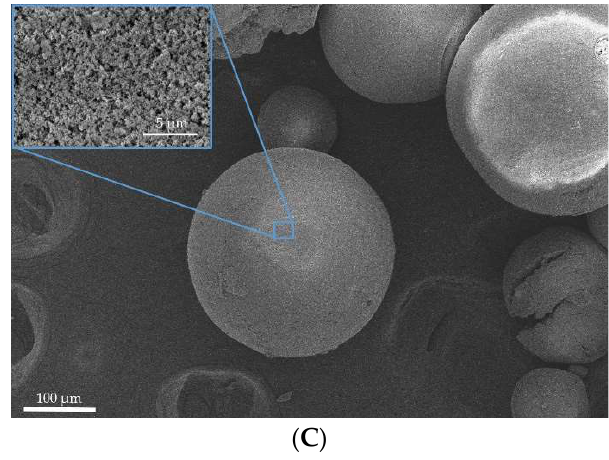
Figure 2. SEM images of the surface of the particles of aerogels based on whey protein isolate: ( A )—sample 4; ( B )—sample 5; ( C )—sample 6.